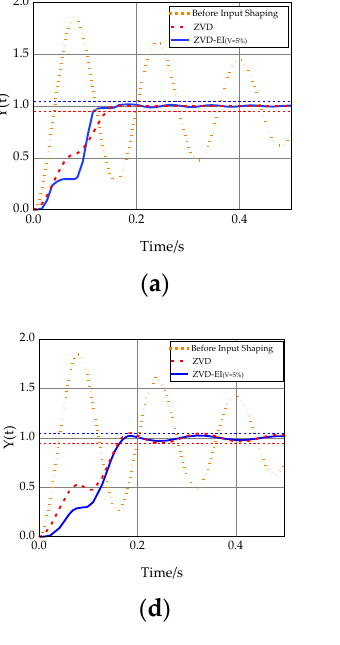
Figure 16. Unit step response of the ZVD-EI dual-modal input shaper and the ZVD single-modal input shaper: ( a ) response when the system modal parameter error value is 0; ( b ) response when the system modal parameter error value is 5%; ( c ) response when the system modal parameter error value is 10%; ( d ) response when the system modal parameter error value is 15%; ( e ) response when the system modal parameter error value is 20%.